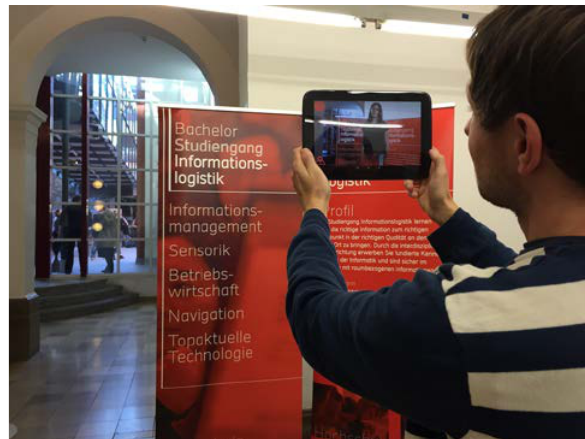
Figure 4. Demonstration of the approach during the exhibition of study paths at the University of Applied Sciences